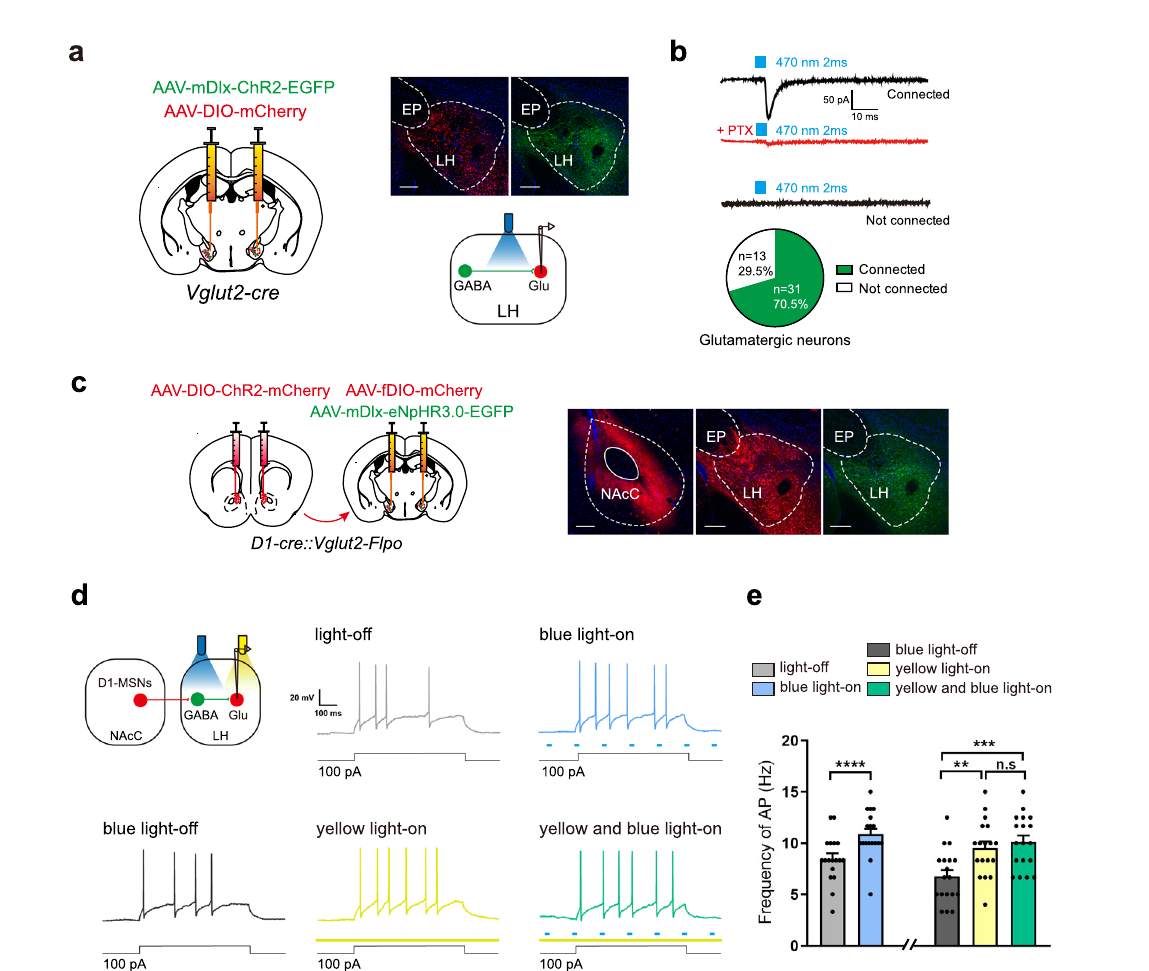
Fig. 5 | The projection of NAcC D1-MSNs to LH and the infulence of morphine withdrawalmemoryonthisprojection.a Top:thediagramofvirusinjectioninto the NAcC (AAV-DIO-ChR2-mCherry) and LH (AAV-mDIx-EGFP and AAV-fDIO- mCherry) in D1-Cre::Vglut2-Flpo mice. Middle: the expression of ChR2-mCherry in NAcC, the expression of mDlx-EGFP and fDIO-mCherry in LH (Scale bar, 200 μ m). Bottom:theschematicsofthewhole-cellpatchrecording. b Left:therepresentative IPSCs evoked in connected and non-connected LH glutamatergic neurons by the lightstimulation(bluelight,470nm,2ms).Right:thepercentageofconnectedand non-connected LH glutamatergic neurons ( n =25 cells of 5 mice). c Left: the representative IPSCs evoked in connected and non-connected LH GABAergic neuronsbylightstimulation(bluelight,470nm,2ms).PTX(100 μ M)blockedlight- evoked IPSCs. Right: the percentage of connected and non-connected LH